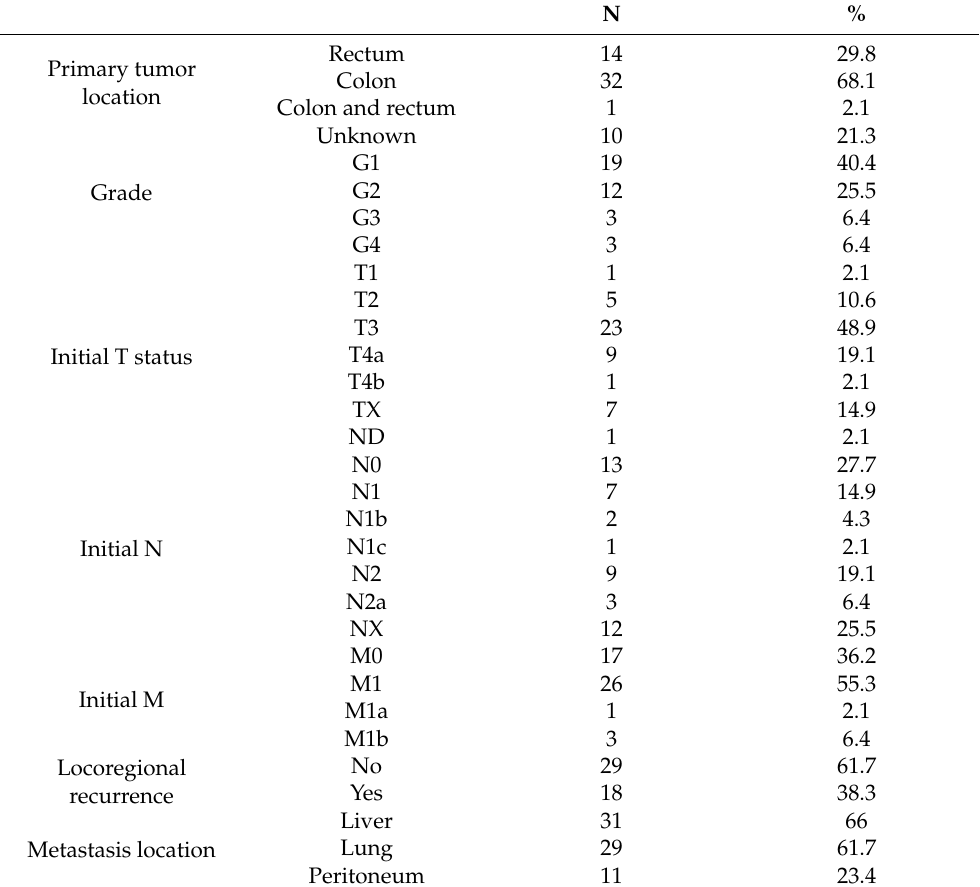
Table 2. Primary tumor features of colorectal cancer patients used in the study. Data regarding primary tumor location, grade, T stage, N stage, M stage, locoregional recurrence, and metastasis location are